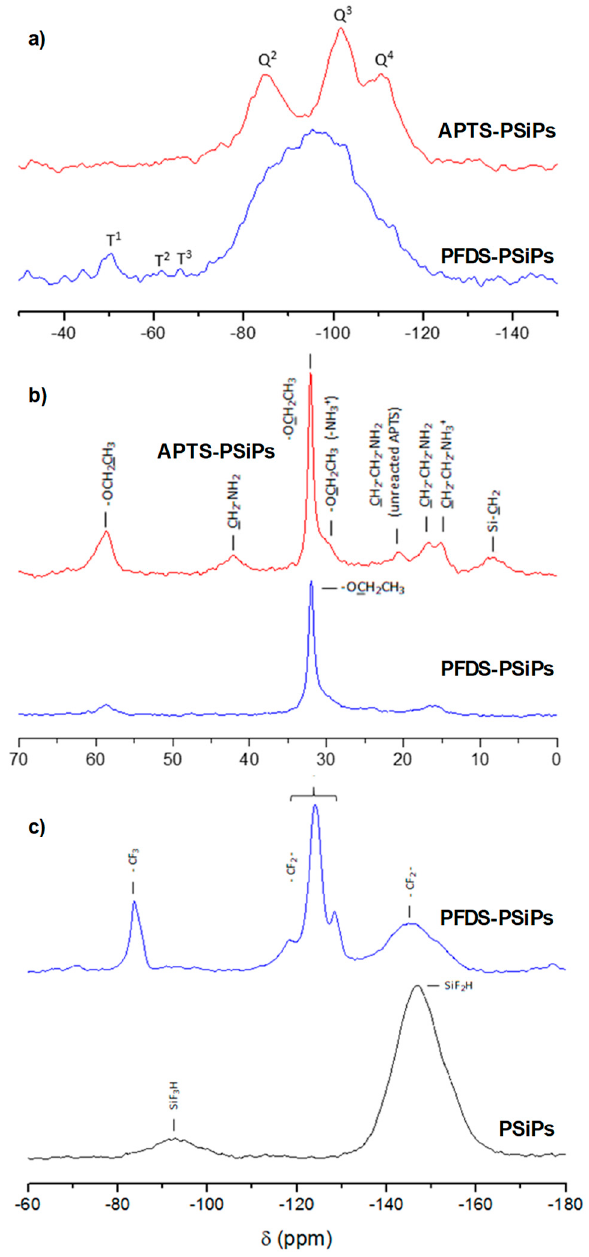
Figure 7. 29 Si ( a ) and 13 C ( b ) nuclear magnetic resonance (NMR) spectra of the APTS and PFDS functionalized PSiPs. 19 F NMR spectra of PFDS PSiPs and fresh PSiPs ( c ).